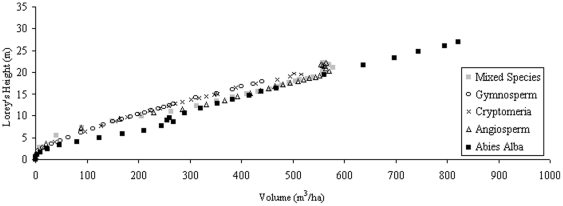
HLorey against forest volume for planting densities of 10,000 ha.−1.